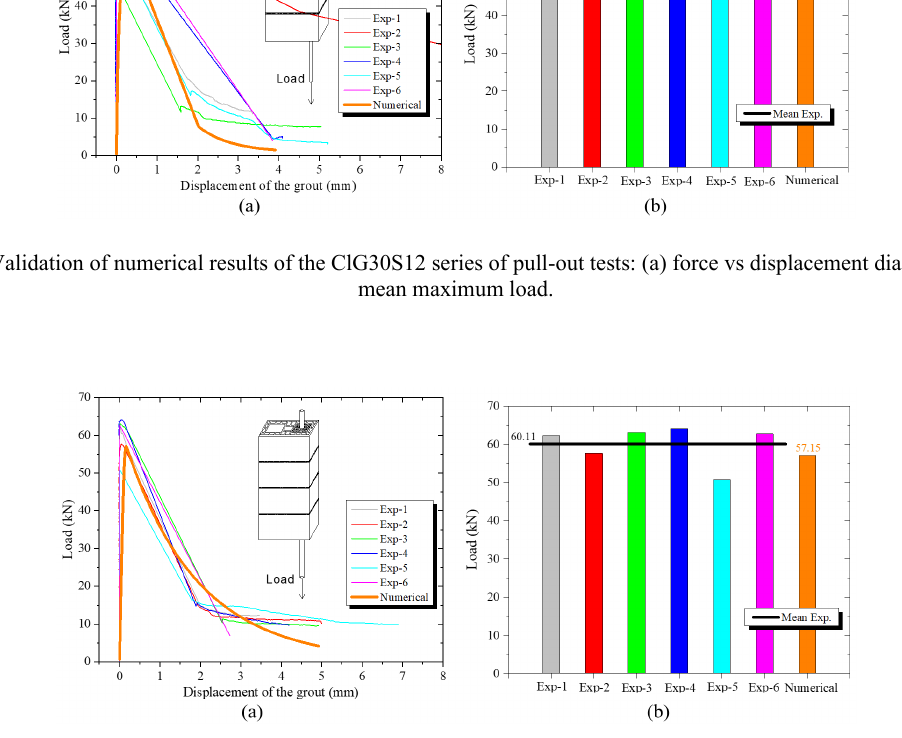
Figure 15. Validation of numerical results of the ClG30S16 series of pull-out tests: (a) force vs displacement diagrams and (b) mean maximum